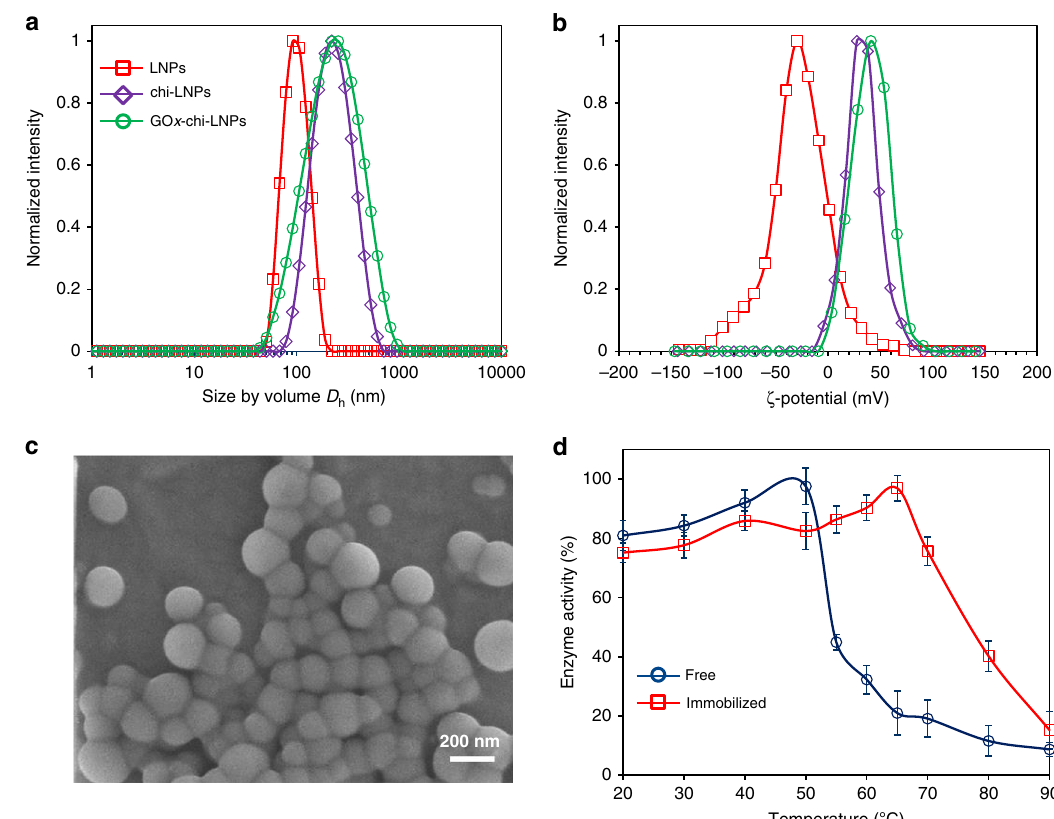
Fig. 2 Characterization of GOx-chi-LNPs. a Hydrodynamic diameter and b ζ -potential distributions of lignin nanoparticles employed in this work. (red squares) LNPs, (purple diamonds) chi-LNPs and (green circles) GOx-chi-LNPs. The mean values ± SD ( n = 3) of the particle diameter and ζ -potential results in a , b are given in Supplementary Table 2. c SEM image of GOx-chi-LNPs. d Thermal stability of (blue circles) free and (red squares) immobilized GOx. Mean values ± SD ( n = 3) are